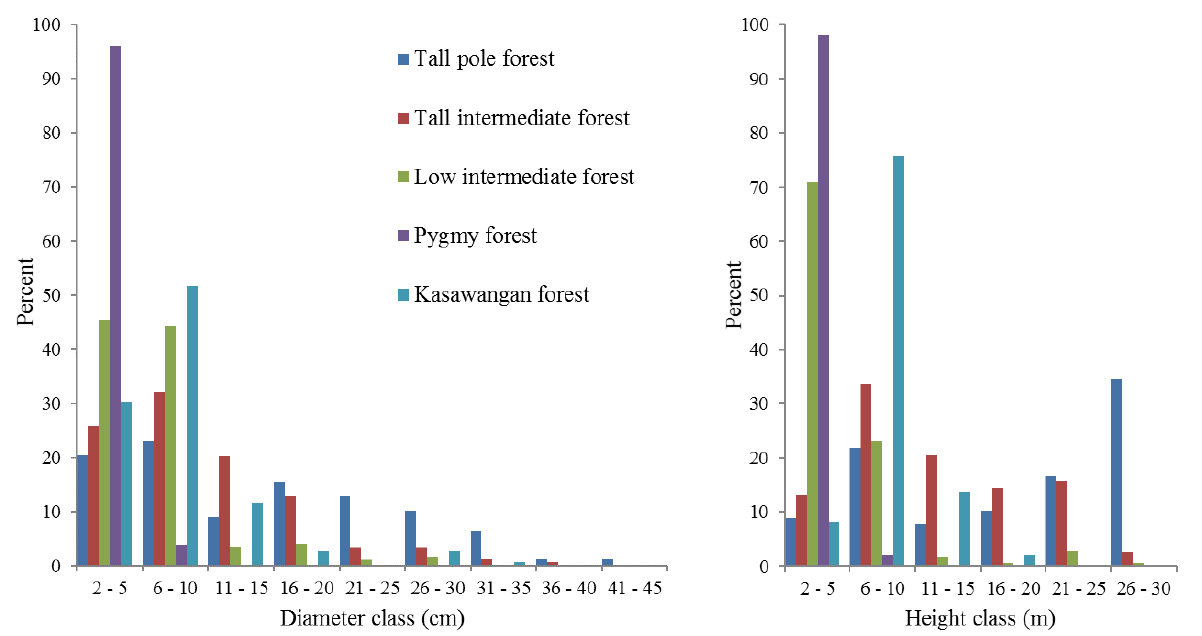
Figure 2. Left: tree DBH categories (percentage of trees with DBH ≥ 2 cm); right: tree height data (percentage of trees in each height category) in the different forest subtypes at